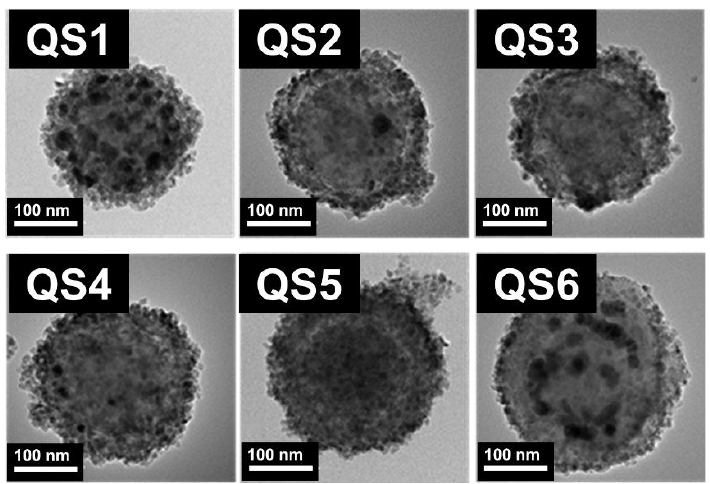
Figure 2. TEM images of SiO 2 @Ag@SiO 2 @QDs using SiO 2 @Ag@SiO 2 with various silica shells thicknesses (S1 to S6) to introduce 7 mg QDs on their surfaces to generate the SiO 2 @Ag@SiO 2 @QDs corresponding to ( QS1 – QS6 ).